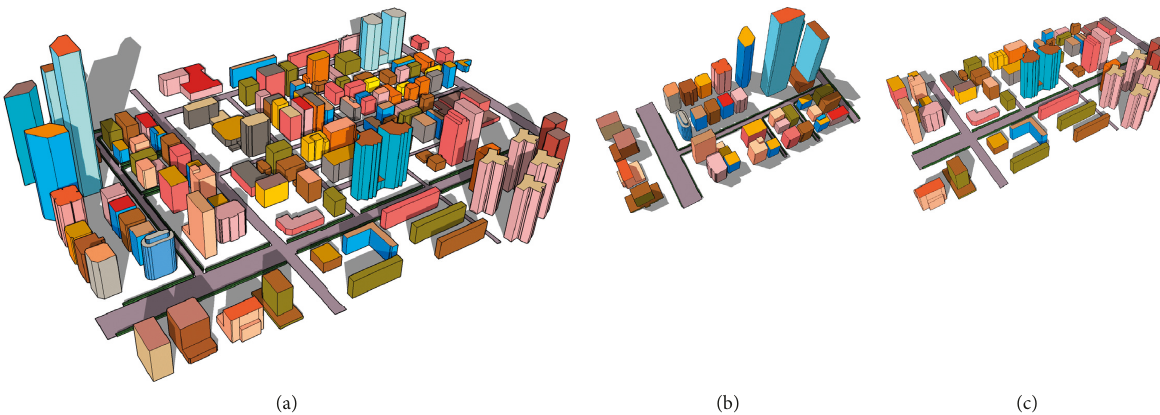
Figure 2: (a) 3D model of Seoul urban environment. (b) 3D model of Area 1. (c) 3D model of Area 2.